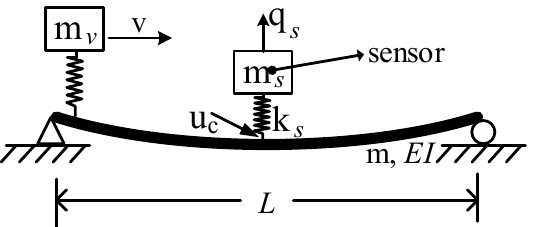
Figure 2. A stationary vehicle parked in the middle of a bridge while another moving vehicle passes over the bridge.